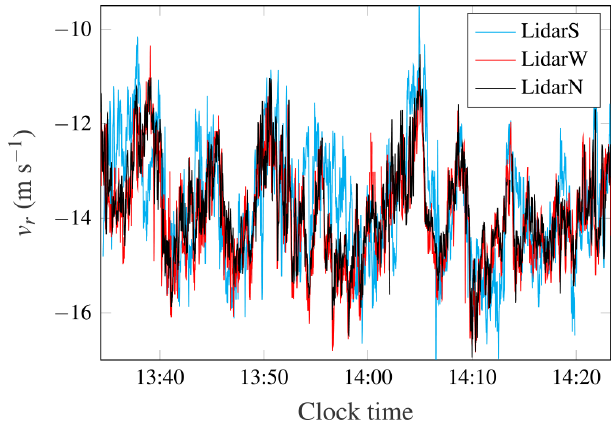
Figure 13. Along-beam velocity component recorded on 25 Octo- ber 2019 by LidarN, LidarS and LidarW at r =